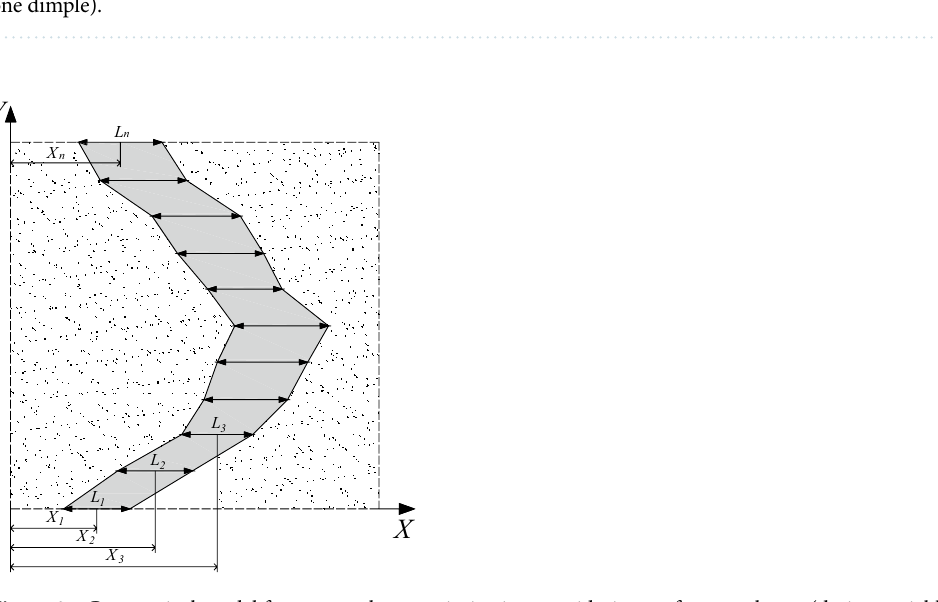
Figure 2. Geometrical model for texture shape optimization considering surface roughness (design variables for an arbitrary texture